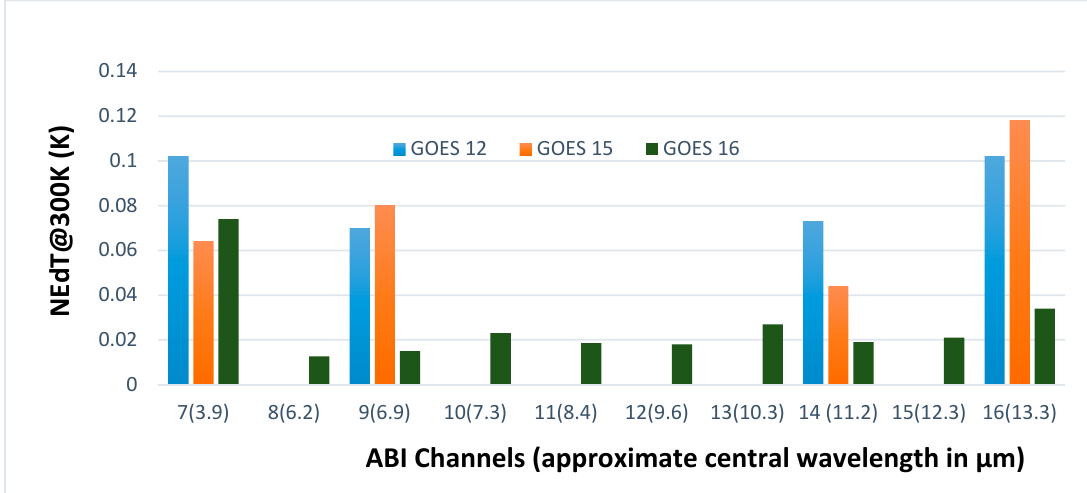
Figure 5. Noise Equivalent change in radiances expressed in units of temperature at 300 K for the legacy Imagers on GOES 12, 15, and ABI on GOES-16. The ABI sensor requirements are NEdT of up to 0.1 K for bands 7–15 and a NEdT of up to 0.3 K for band 16. The central wave lengths of legacy GOES Imager IR bands shown here are close to ABI but not identical (data from the Calibration Working Group, NOAA/NESDIS/STAR).